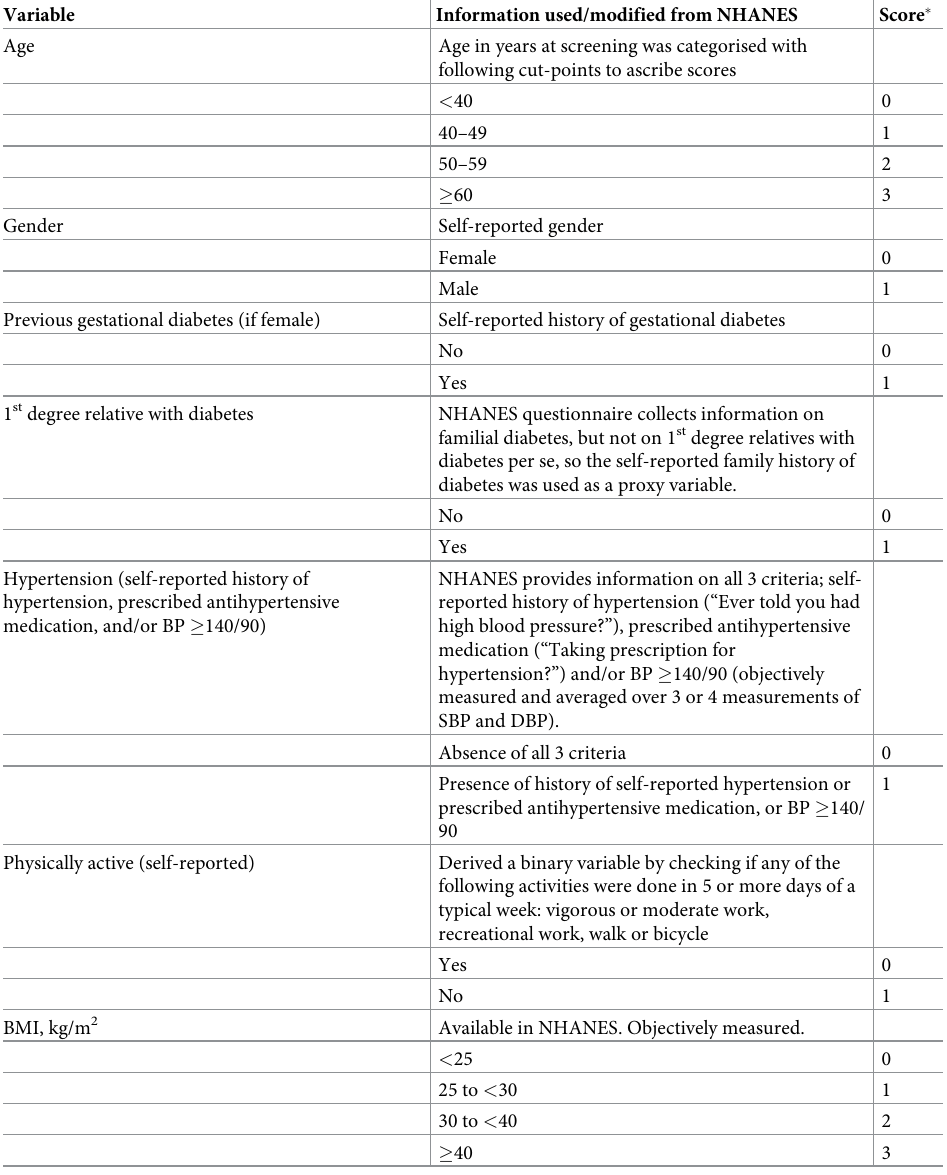
Table 3. Creation of variables analogous to those in the American Diabetes Association (ADA) diabetes risk test using National Health and Nutrition Examination Survey (NHANES)